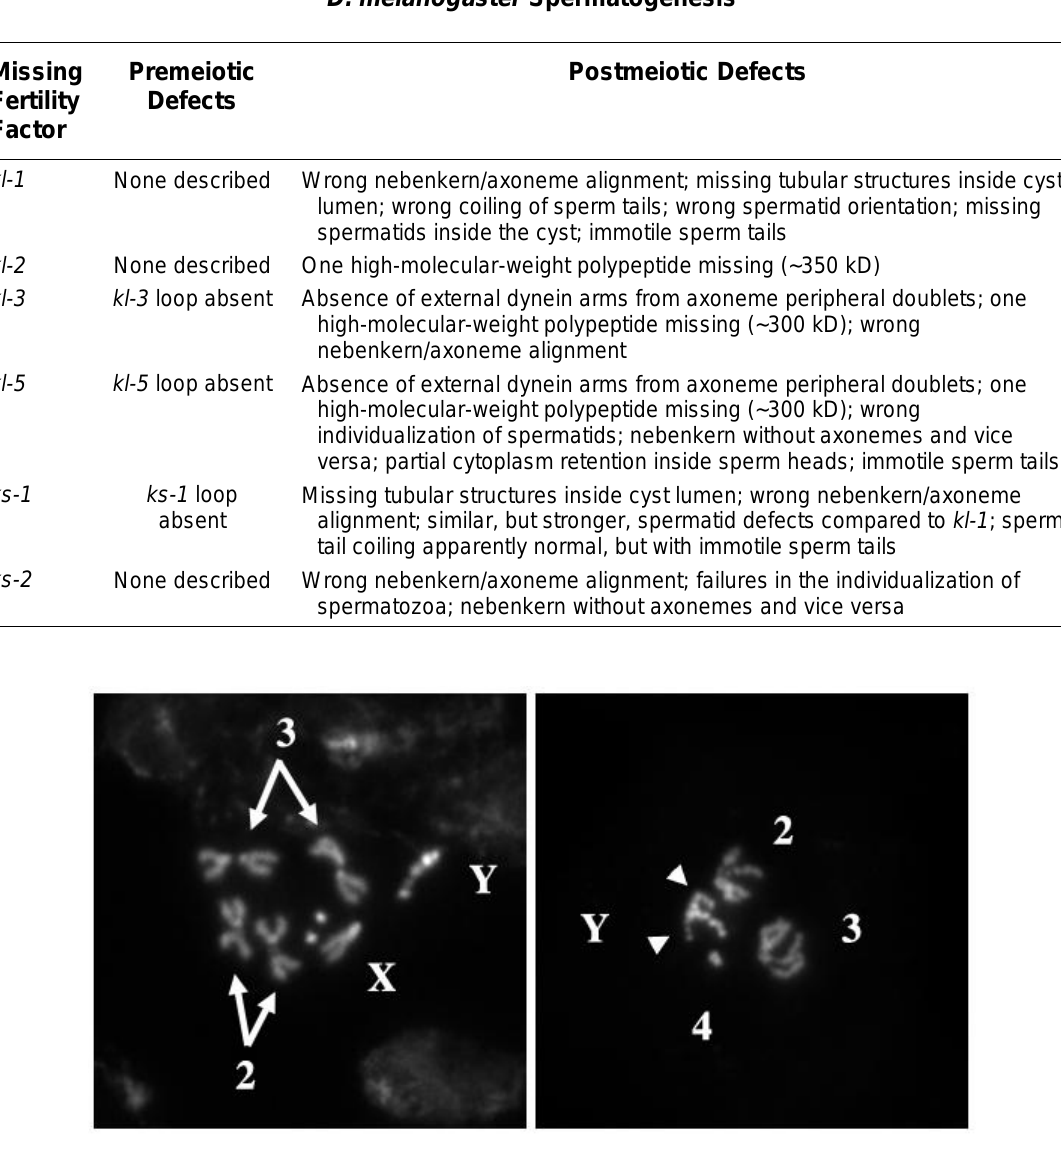
FIGURE 2. Comparison between mitotic (left) and meiotic (right) Y chromosome in the male germ line of D. melanogaster , as they appear with the DAPI dye. Numbers indicate chromosomes (on the left